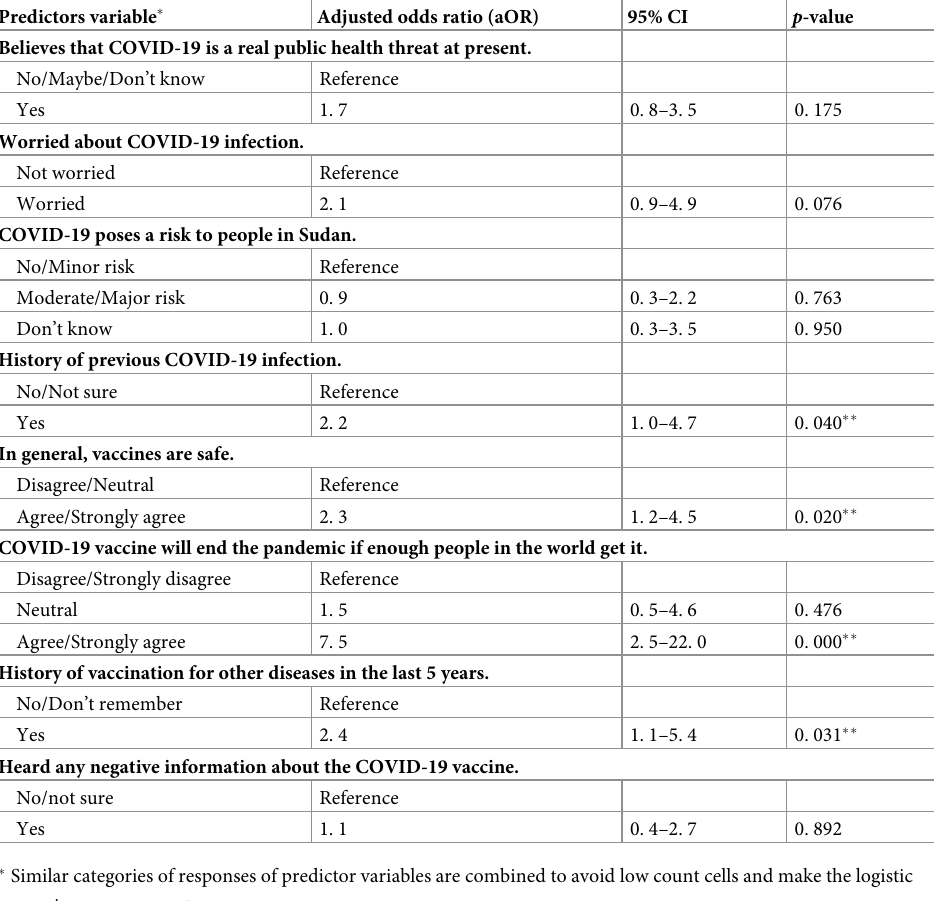
Table 5. Predictors of COVID-19 vaccine acceptance using logistic regression analysis among medical students at IUA, Khartoum, Sudan, 2021 (n = 217). Predictors variable